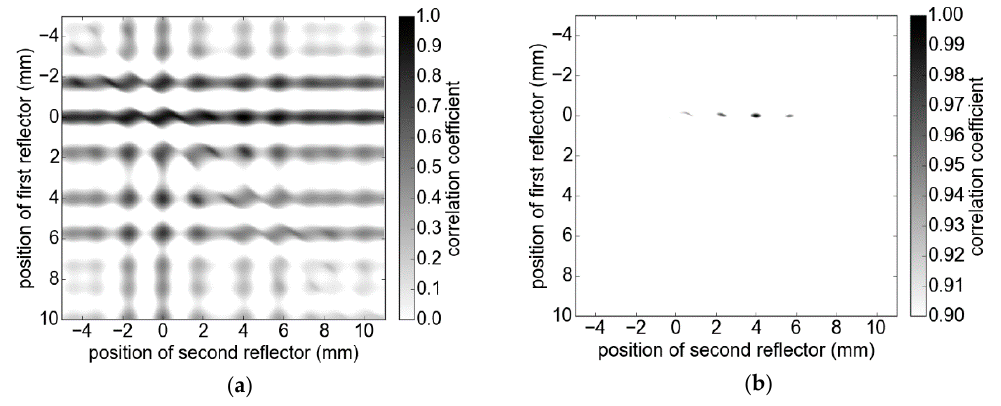
Figure 3. Solution space of the correlation approach for a single layer. The resulting thickness is calculated as the difference of x - and y -values of the maximum. From ( a ) to ( b ), the visibility is enhanced by adjustment of the displayed range of the correlation coefficient (the color version is provided as Supplementary Material).